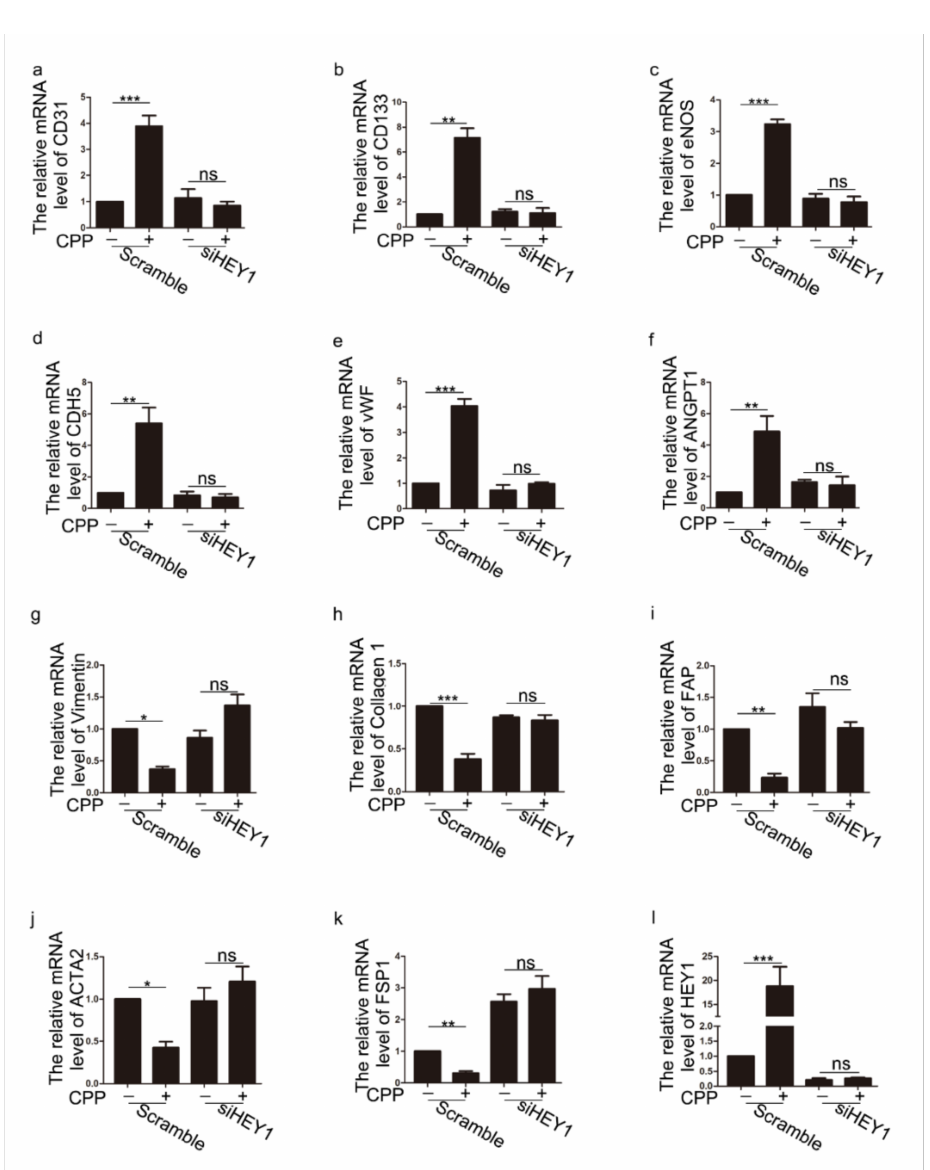
Figure 8. The effect of CPP on related genes after knocking down HEY1. After knocking down HEY1 (siHEY1-1:40 nM), HDFs were treated with CPP (10 µ M) for 6 days, and then the levels of vascular endothelial cell-related genes (CD31, CD133, CDH5, vWF, eNOS and ANGPT1) ( a – f ), and HDFs-related genes (Vimentin, Collagen 1, FAP, ATA2 and FSP1) ( g – k ), and HEY1 ( l ), were analyzed by qPCR. Data are presented as means ± SEM, * p < 0.05, ** p < 0.01, *** p < 0.001, n =